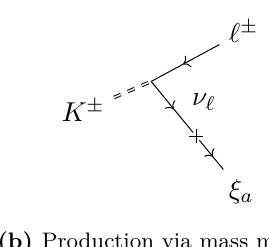
Figure 11. Feynman diagrams for the K ± → ‘ ± ξ a process.